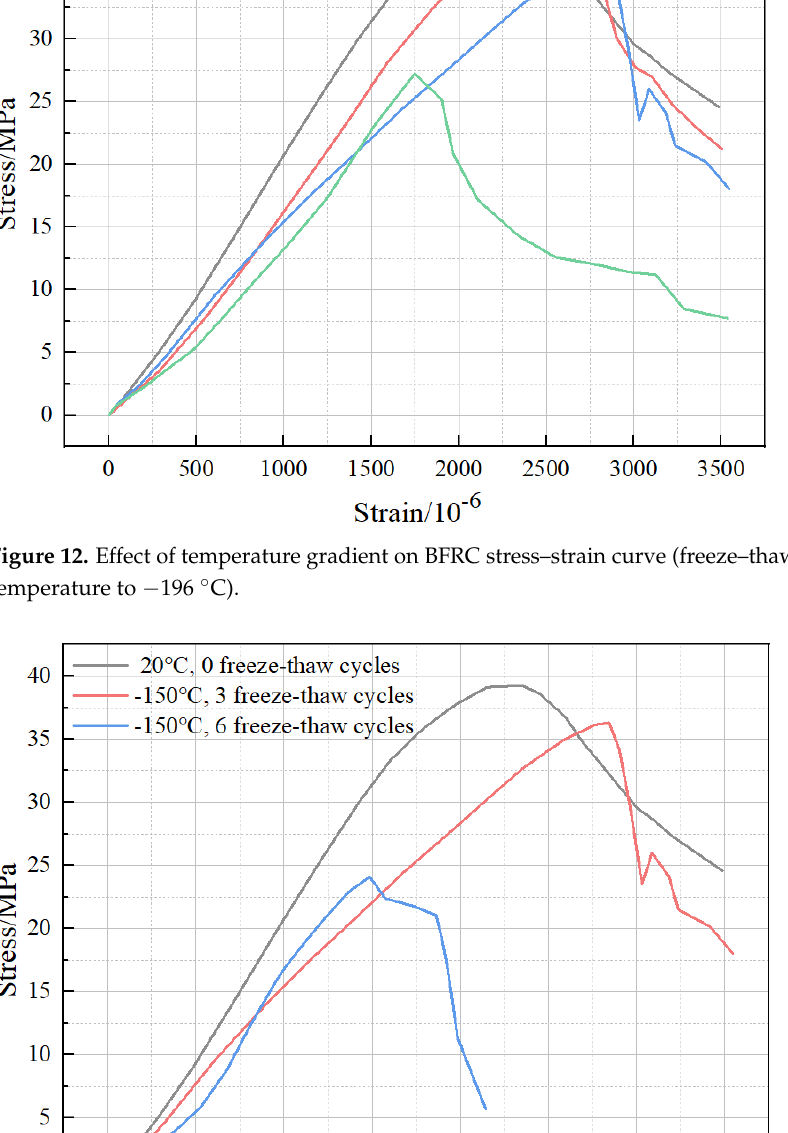
Figure 12. Effect of temperature gradient on BFRC stress–strain curve (freeze–thaw cycles from room temperature to − 196 °C).